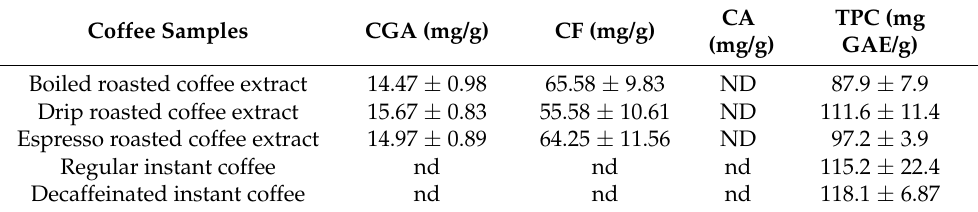
Table 4. Caffeine, chlorogenic acid and total phenolic contentsin coffee samples. Boiled, drip and espresso coffee extracts, and the authentic standards including caffeic acid (CA), caffeine (CF) and chlorogenic acid (CGA), were subjected to HPLC-DAD analysis, as has been described in Section 4.5. Total phenolic contents in the coffee extracts and instant coffee were determined using the Folin- Ciocalteu method, as has been described in Section 4.6. Data obtained from three repetitions are expressed as mean ± standard deviation (SD) values.